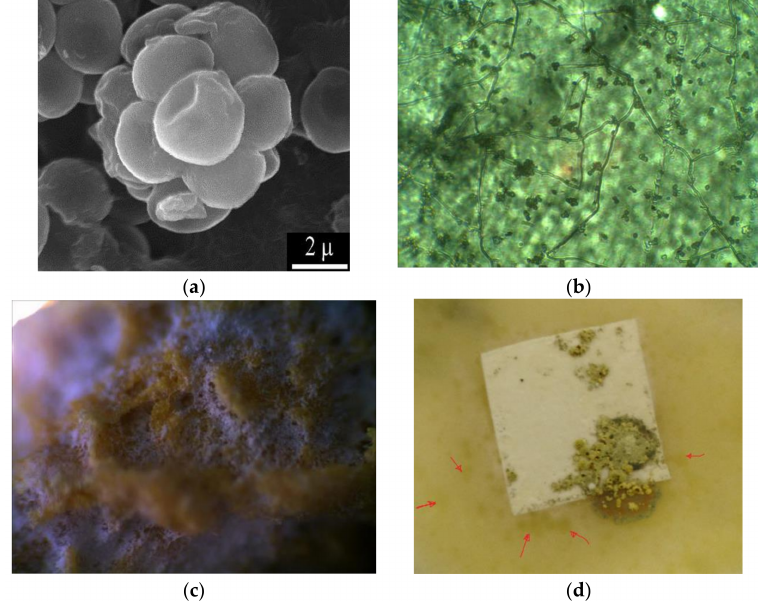
Figure 2. Micromorphology of viable spores of the test strain Trichoderma viride Pers. ex Fr.: scanning electron microscopy ( a ); micromorphology of growth of T. viride on a film of carboxymethyl